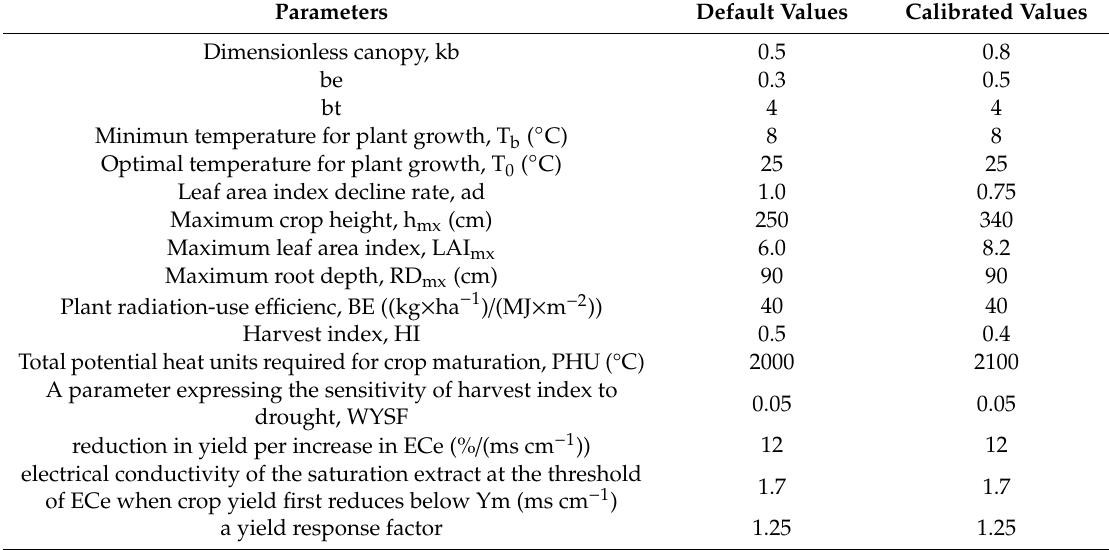
Figure 1. The schematic of the soil water balance calculation and crop growth in the modified AWPM-SG model. Table 4. Default and calibrated values of maize’s physiological parameters for the crop growth part of modified